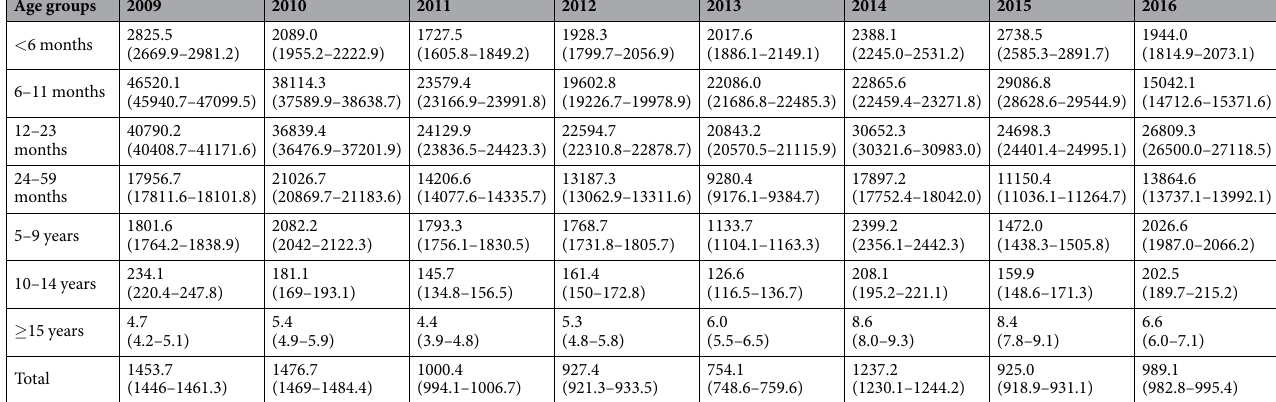
Table 1. Incidence rates (per million) of HFMD by age groups in Shandong province, 2009–2016.